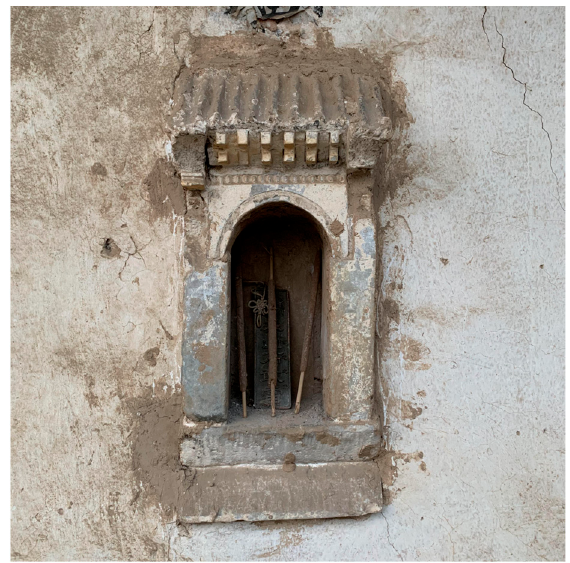
Figure 7. Tile wall decorations. Photo by W. Rong.